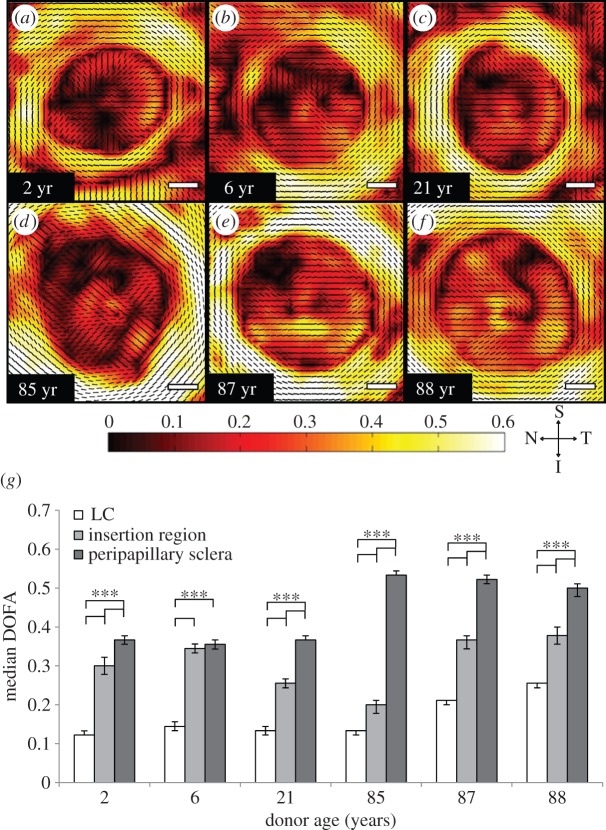
(a–f) DOFA colour maps of different aged ONHs indicate that there is an order of increasing fibre alignment from LC to insertion region to ppsclera. Scale bars, 500 µm. (g) Median (±95% CIs) DOFA was greatest in the ppsclera, compared with that within the region of insertion and LC (***p < 0.0003). The region of insertion DOFA was greater than that in the LC (***p < 0.0003). Bonferroni adjusted significant differences were determined using the Mann–Whitney U-test.